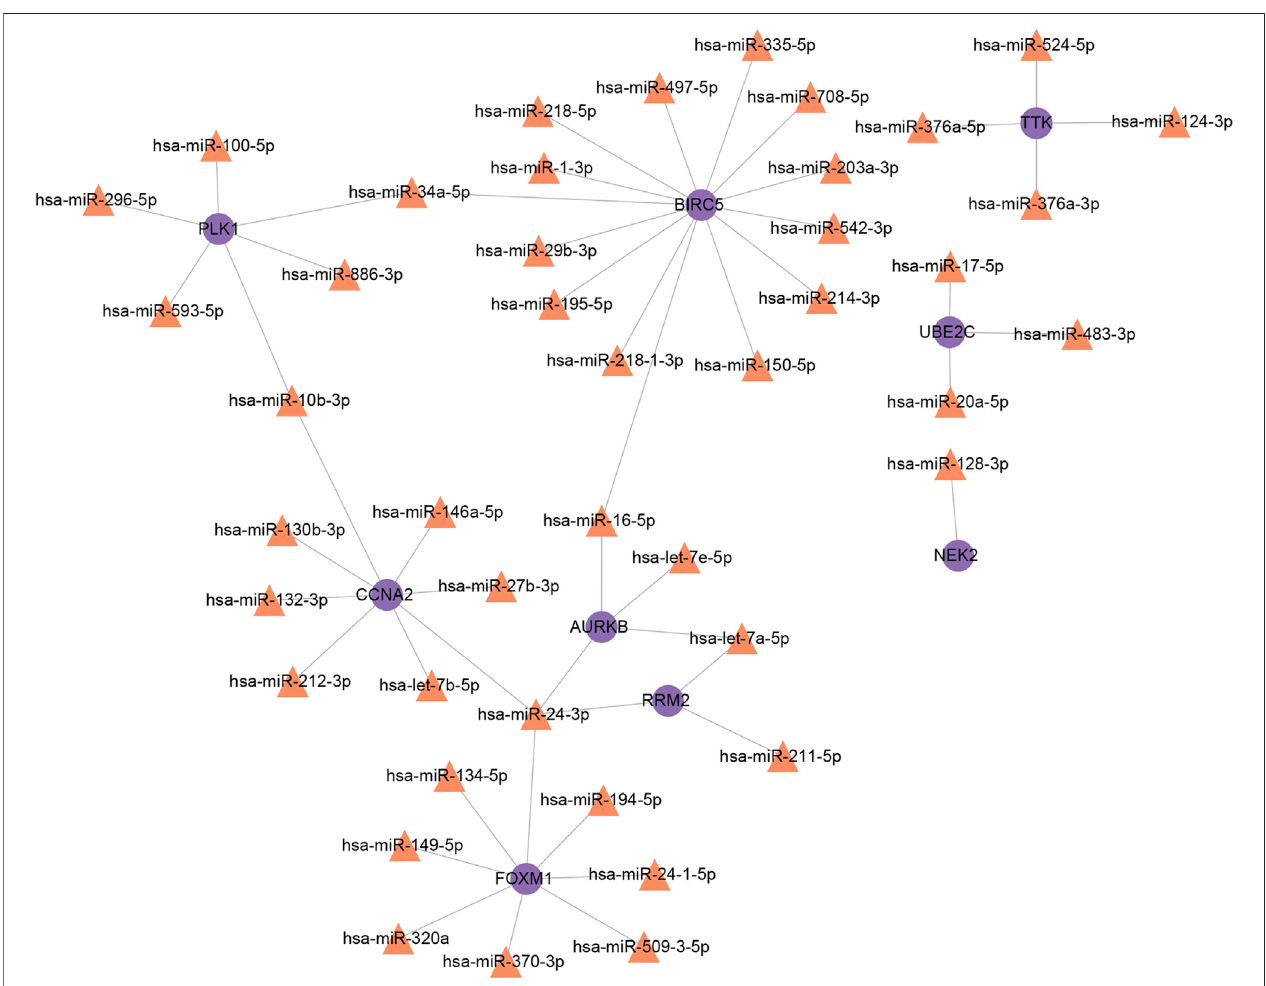
FIGURE8| MiRNAs – interactionalhubgenesinteractionnetwork.Note:purplenodesrepresentgenes,orangenodesrepresentMiRNAs,andedgesrepresentthe interactions between nodes.